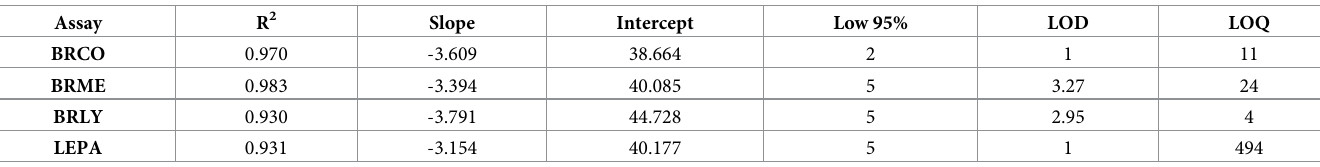
Table 4. Limit of detection (LOD) and limit of quantitation (LOQ) for each assay. Assay R 2 Slope BRME BRLY LEPA LOD and LOQ for assay as calculated from a standard curve using cycle quantification (Cq) mean and standard deviation. “Low 95%” refers to the concentration (in copy number) of the lowest standard with 95% replicates